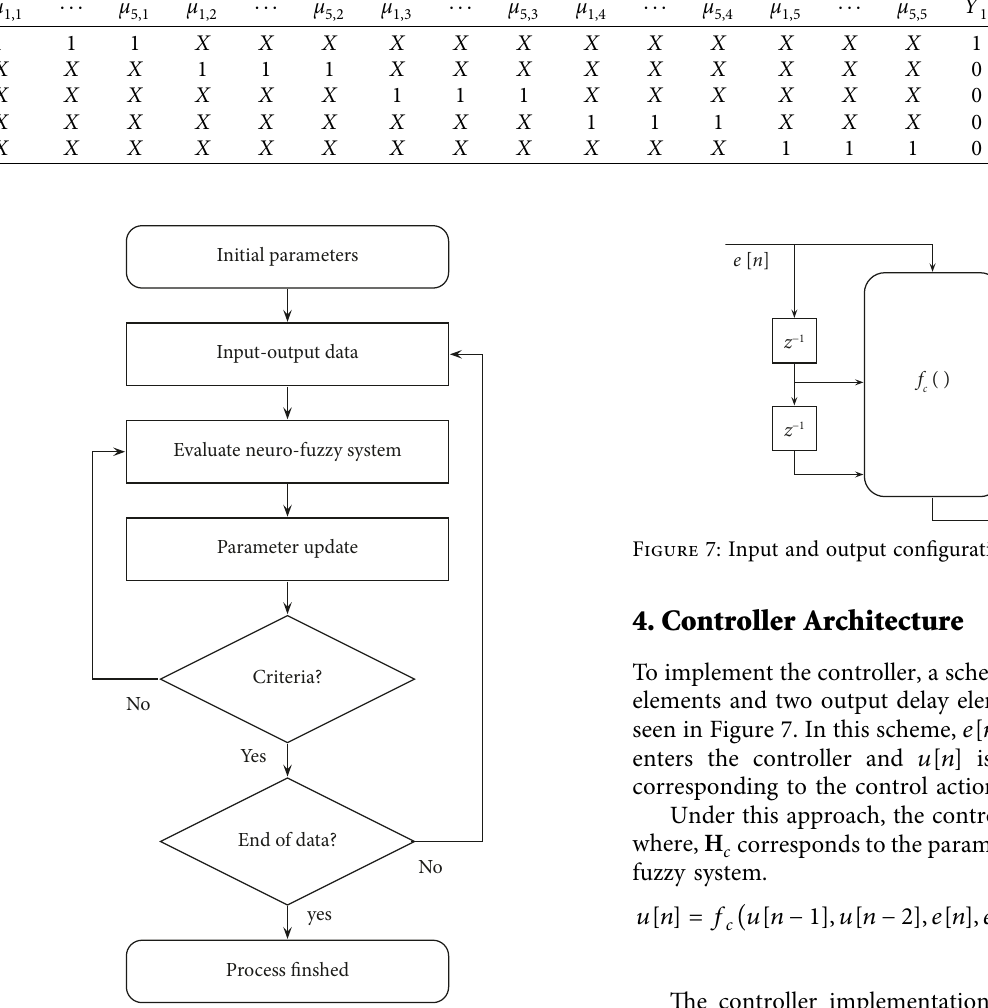
Figure 6: Algorithm for plant identification.